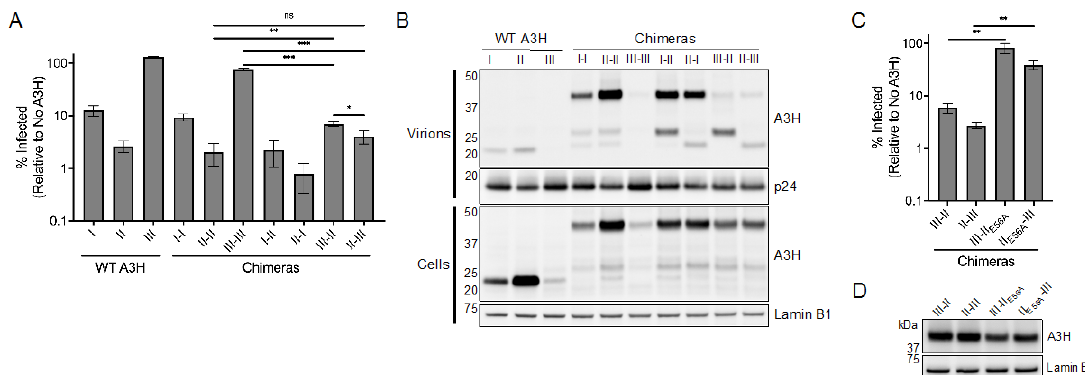
Figure 5. Stabilized and packaged A3H haplotype III is unable to restrict HIV-1. ( A ) Single-cycle infectivity assays performed with vif -deficient HIV-1 virus produced in the presence of the indicated wild-type A3H haplotypes or chimeras. Shown is the average of three biological replicates with error bars indicating the standard deviation of the mean. * p < 0.05, ** p < 0.01, *** p < 0.001, ns = not significant ( p > 0.05), unpaired t test. ( B ) Immunoblot of viral supernatant (Virus, top) and whole cell lysate (Cells, bottom) of virus producing cells as in ( A ) using anti-A3H to assess levels of A3H packaged in virus or expressed in cells. Anti-p24 and anti-Lamin B1 were used as loading controls for virus and cell lysate, respectively. ( C ) Single-cycle infectivity assays performed with vif -deficient HIV-1 virus produced in the presence of the indicated A3H chimeras. Shown is the average of three biological replicates with error bars indicating the standard deviation of the mean. ** p < 0.01, unpaired t test. E56A is a mutation at the catalytic active site of hap II ( D ) Immunoblot of indicated A3H chimeras expressed in 293T cells. Western blotting of whole cell lysates was performed using anti-A3H and anti-Lamin B1 as a loading control.